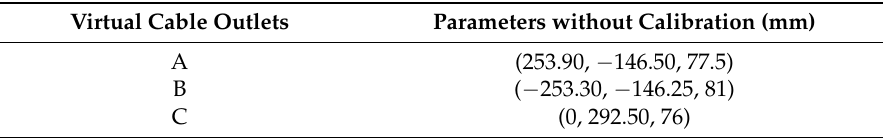
Table 4. The initial measurement of the virtual cable outlets.